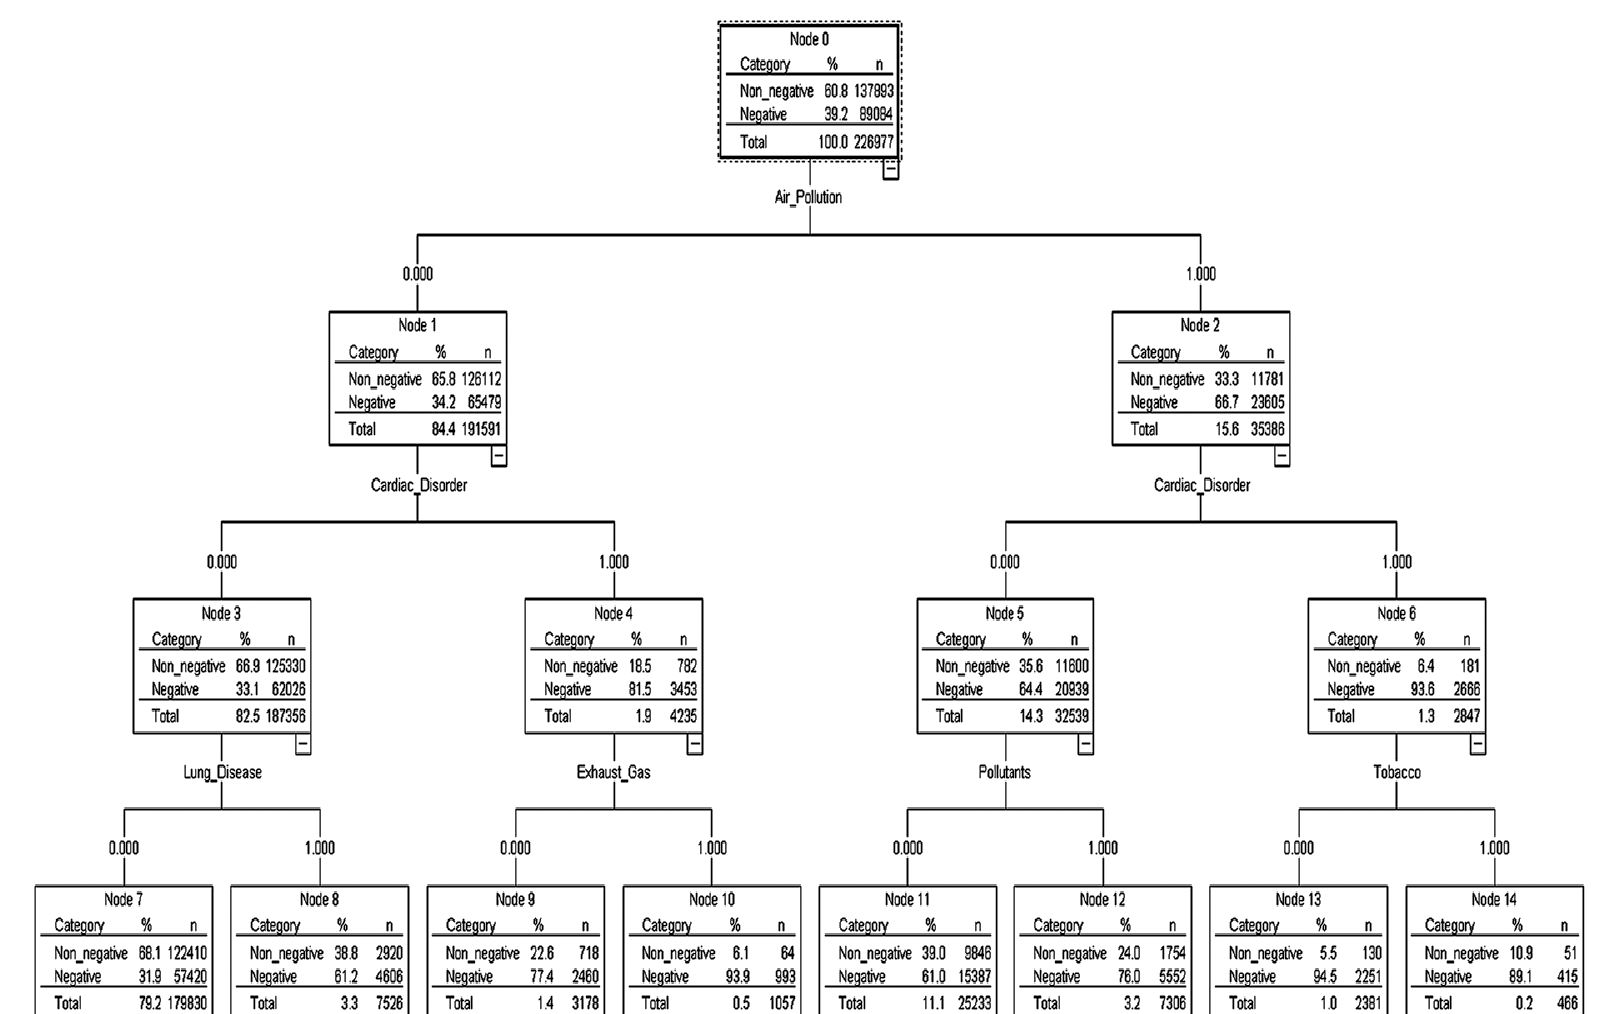
Figure 2. Decision-Tree Model of Cause-and-Disease Factor.